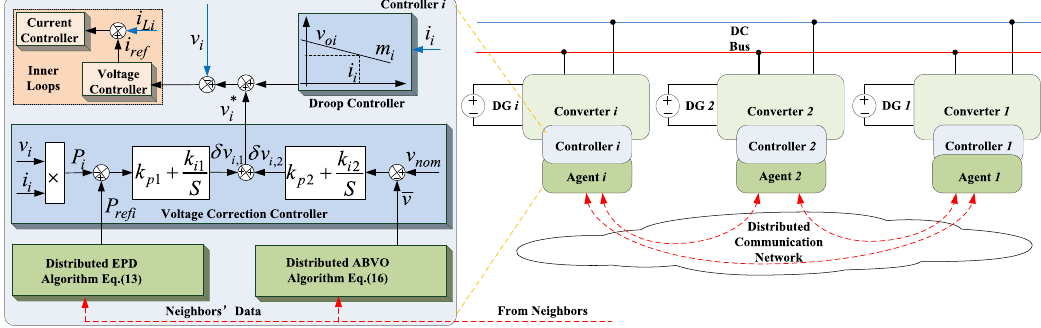
Figure 3. Proposed distributed optimal bus voltage control for droop-controlled DC microgrids. EPD, economic power dispatch; ABVO, average bus voltage